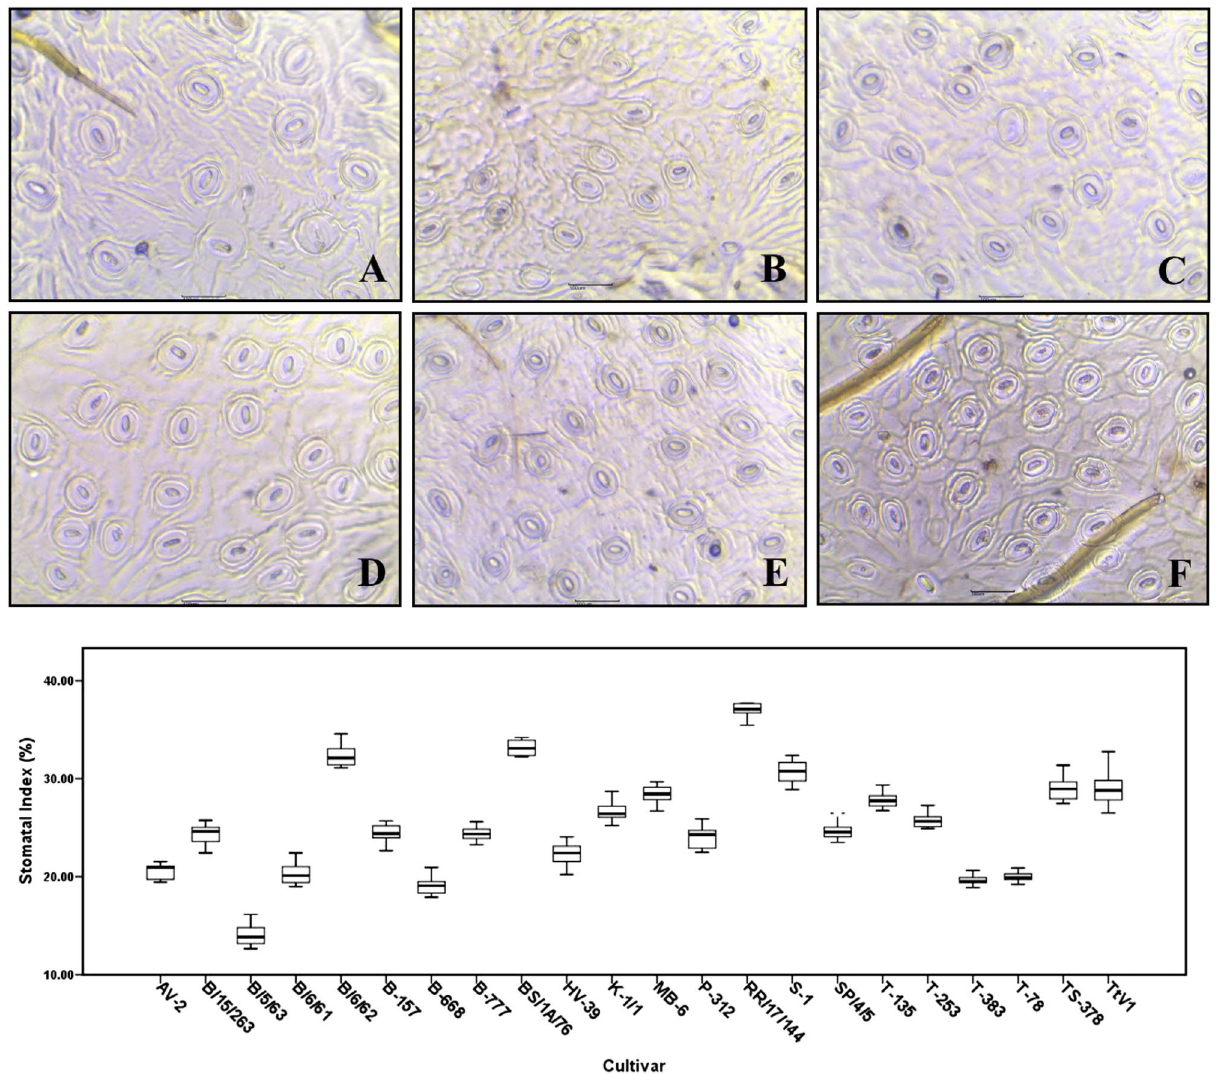
Figure 1. Measurements of stomatal indices; ventral epidermal surfaces of representative cultivars, ( A ) B/5/63, ( B ) AV2, ( C ) B668, ( D ) K1/1, ( E ) P312, and ( F ) RR/17/144; box plot showing mean stomatal indices for studied 22